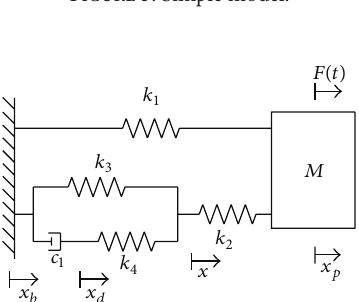
where 𝑑 and 𝐷 are the diameters of the damping orifice and fluid reservoir, respectively, and 𝑉 is the relative velocity between the two ends of fluid reservoir.